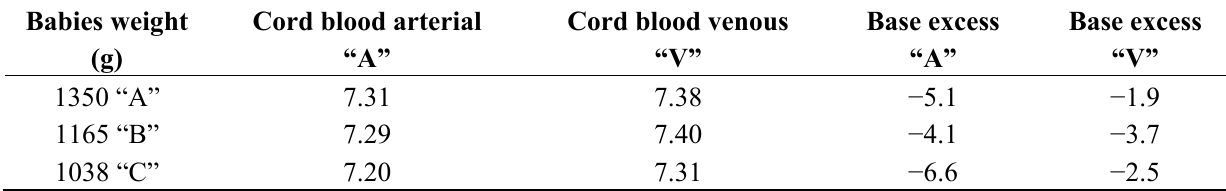
Table 1. Birth weight and venous and arterial cord bloods of the triplets. Babies